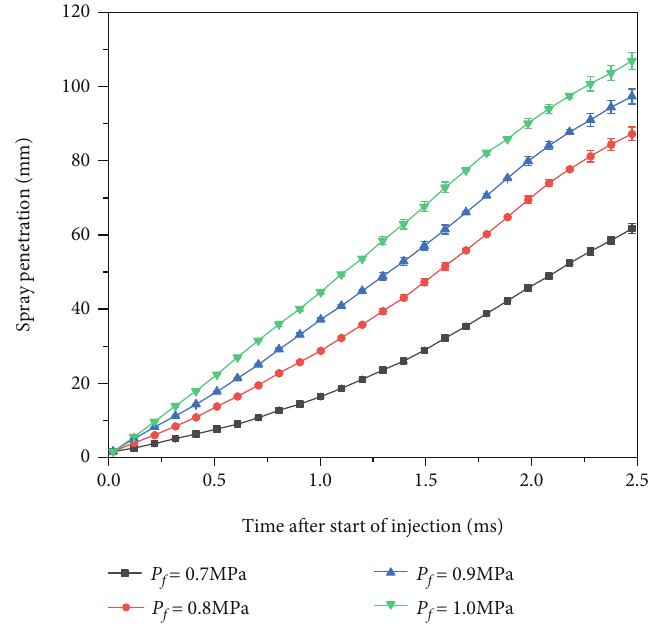
= 298K , Δ T = 4 : 0ms ). f f